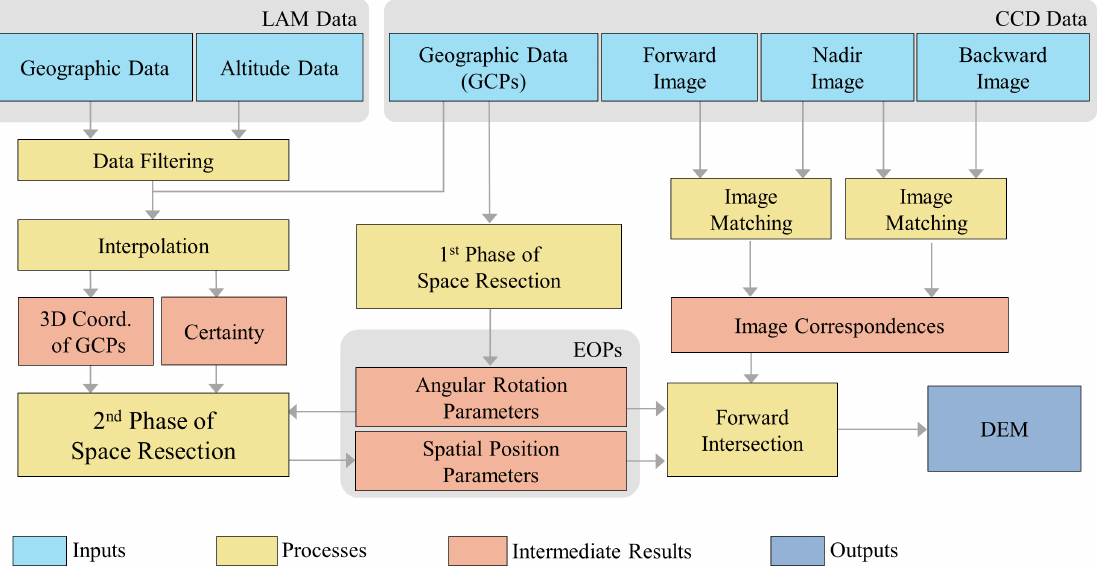
Figure 3. The framework of our